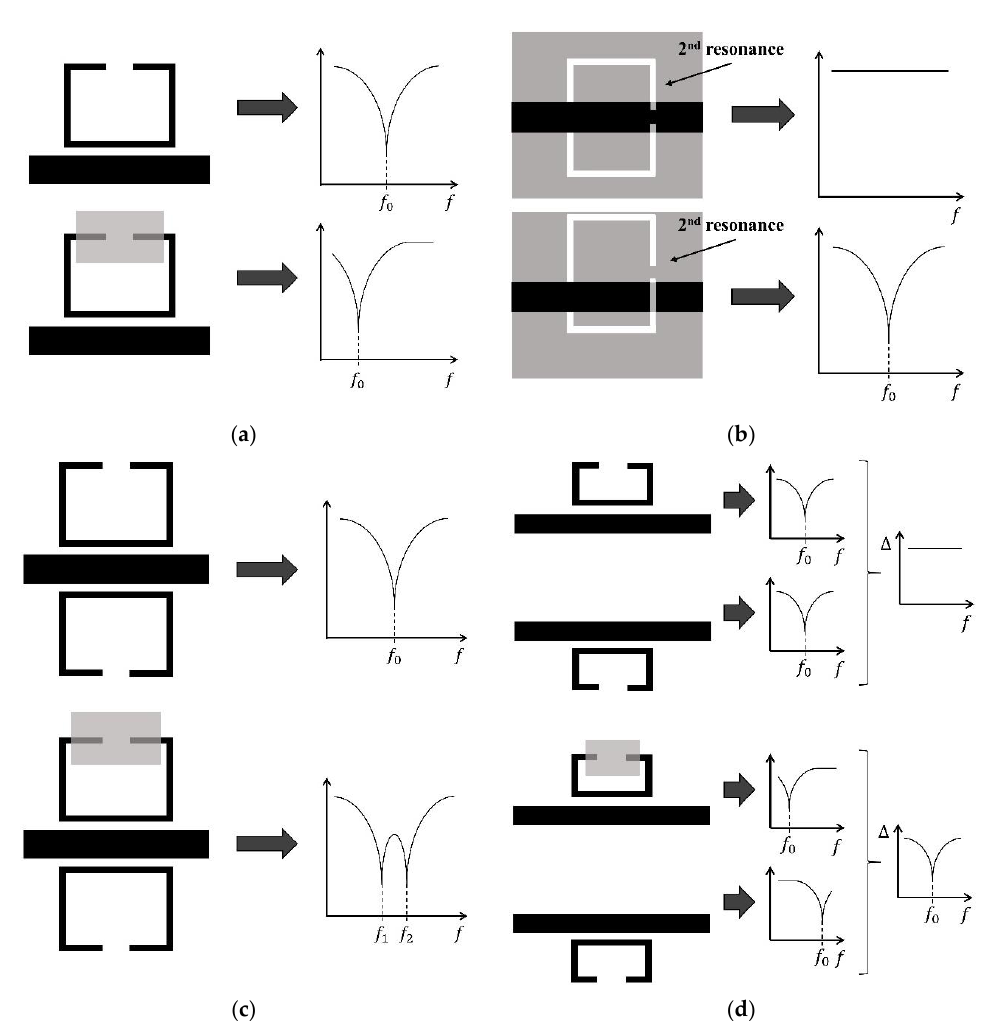
Figure 1. Typical topology and working principle of the considered planar microwave resonant sensors. ( a ) Frequency variation; ( b ) coupling modulation; ( c ) frequency splitting; ( d ) differential- mode.